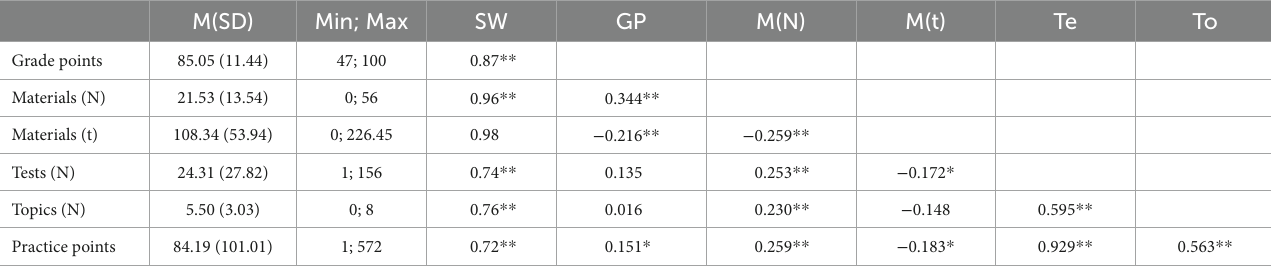
TABLE 2 Descriptive statistics and correlations – BA courses.